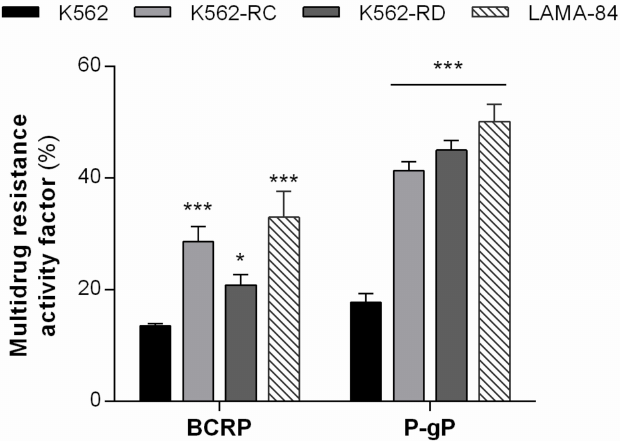
Figure 1. ABC transporters activity in CML models. The multidrug resistance activity factor (MRAF) represented the BCRP and P-gP activity in our cell lines and was determined using the eFluxx-ID ® Green Multi-Drug Resistance Assay kit. Results are expressed as a percentage (%) and represent the mean ± SEM obtained from five independent experiments. * p < 0.05; *** p < 0.001 (comparison with sensitive K562 cells).